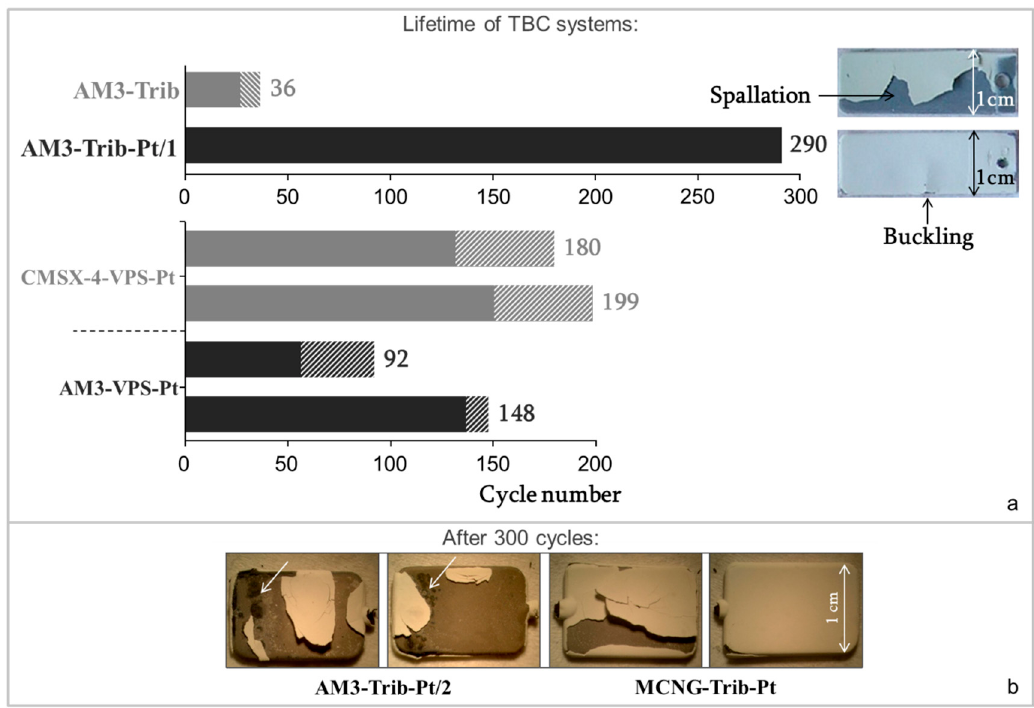
Figure 2. ( a ) Lifetime at 25% of spallation or buckling for AM3-Trib, AM3-Trib-Pt/1, AM3-VPS-Pt and CMSX-4-VPS-Pt TBC systems, and pictures of AM3-Trib and AM3-Trib-Pt/1 TBC systems after failure. The hatched areas represent the lifetime uncertainty; ( b ) Pictures of both sides of AM3-Trib-Pt/2 and MCNG-Trib-Pt/2 TBC systems after 300 cycles. The arrows indicate areas of catastrophic degradation. Thermal cycles of 1 h at 1100 °C, with a high-flow air cooling.